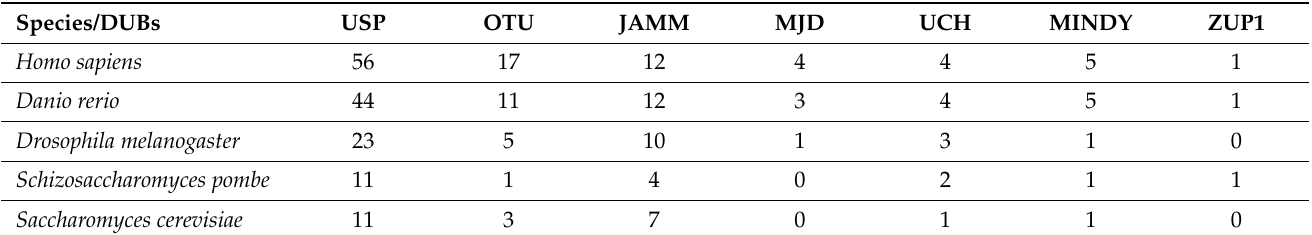
Table 1. The seven classes of deubiquitinating enzymes